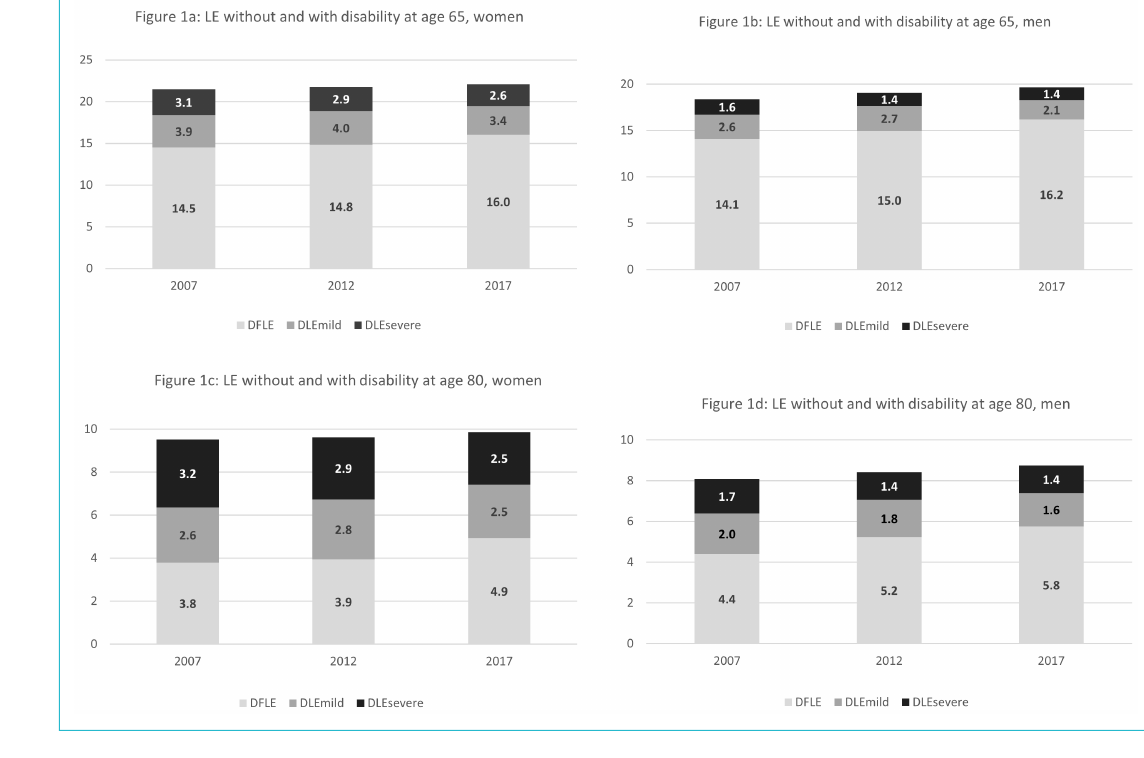
Figure 1: Trend in life expectancy without (DFLE), with mild (DLE mild ), and with severe (DLE severe ) disability at 65 and 80 years of age, by sex. Mean values for DFLE and LED mild and LED severe